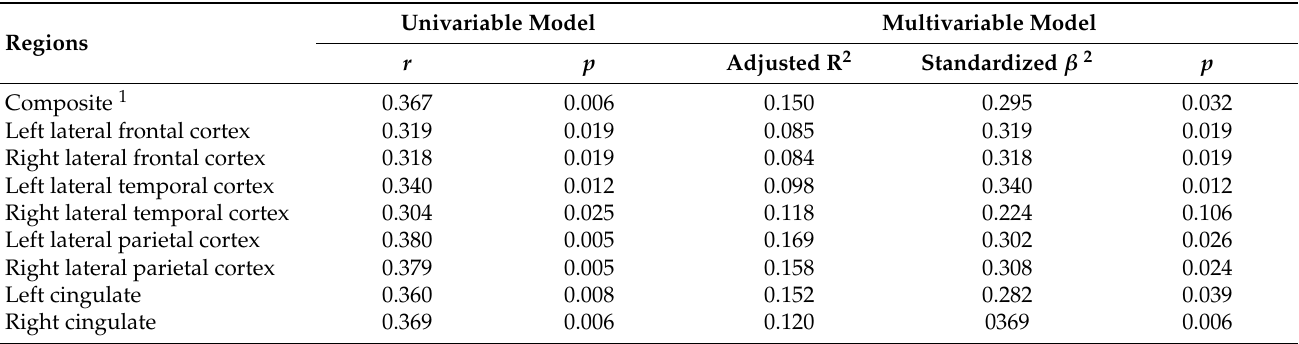
Table 5. Association between visceral adipose tissue SUV mean and cerebral A β burden in the over- all